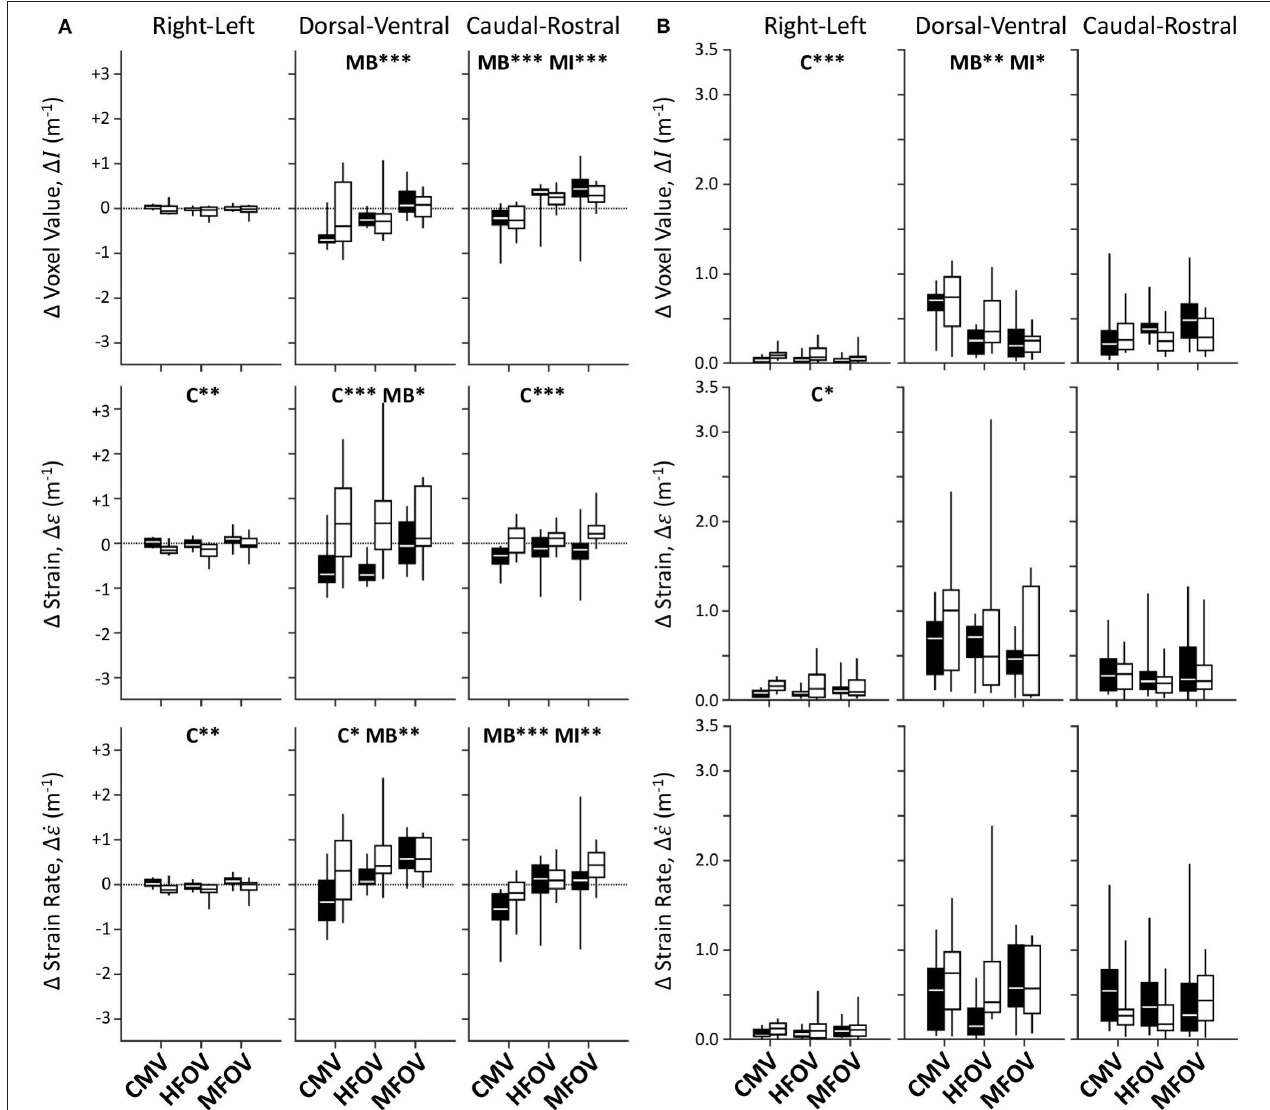
FIGURE 8 | Mean-normalized spatial gradient values (A) and magnitudes (B) for image registration-based regional ventilation measures of intratidal changes in aeration ( 1 I ), volumetric strain ( 1ε ), and volumetric strain rate ( 1 are shown for each variable, represented by box plots showing minimum, maximum, and quartiles across subjects under baseline (black) and injured (white) conditions, during conventional mechanical ventilation (CMV), high-frequency oscillatory ventilation (HFOV), and multi-frequency oscillatory ventilation (MFOV). Asterisks indicate significance levels (* p < 0.05, ** p < 0.01, *** p < 0.001) for main effects (C injured condition). See Table 2 for additional